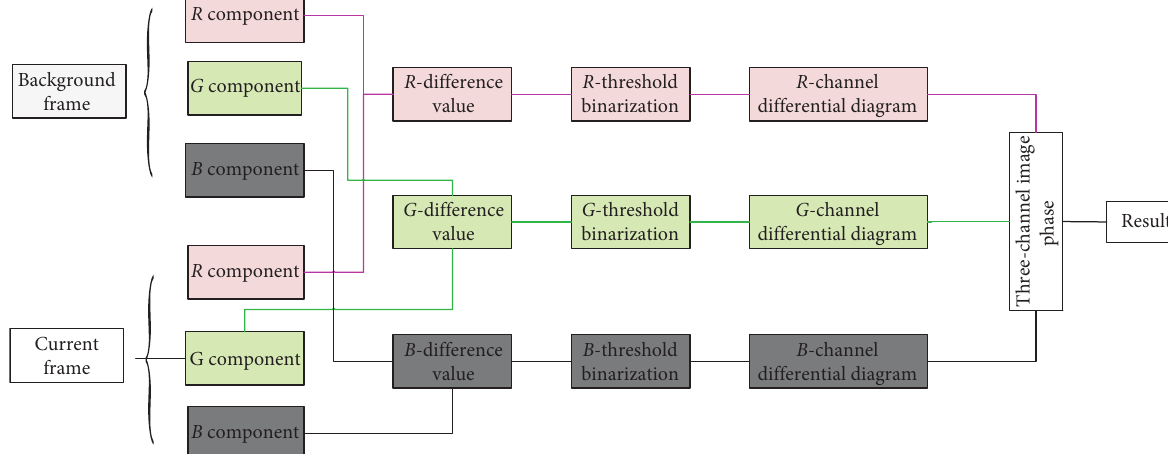
Figure 5: The overall design framework of the monitoring system for training